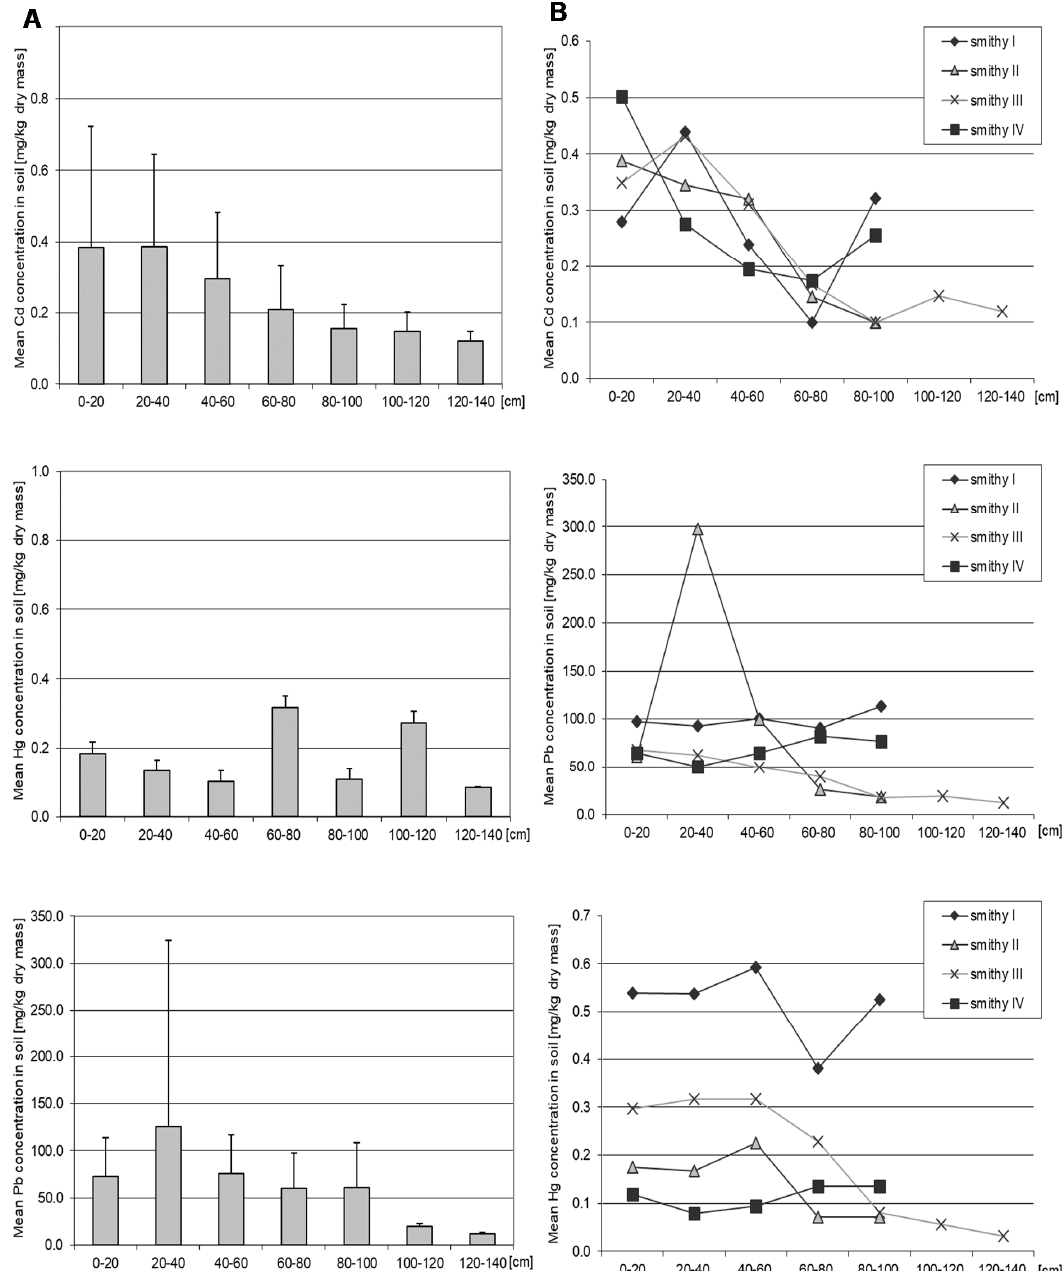
Figure 3. Mean soil Cd, Pb, and Hg levels depending on the depth of sampling ( A ) and depending on the site and the depth of sampling ( B ). Data represent the means ± SD for 3 independent measurements. There is no statistically significant differences in Cd, Pb, and Hg concentration depending on the depth of sampling (Mann-Whitney U test). Statistically significant differences depending on the site of sampling (Wilcoxon test) see Supplementary Table S2.